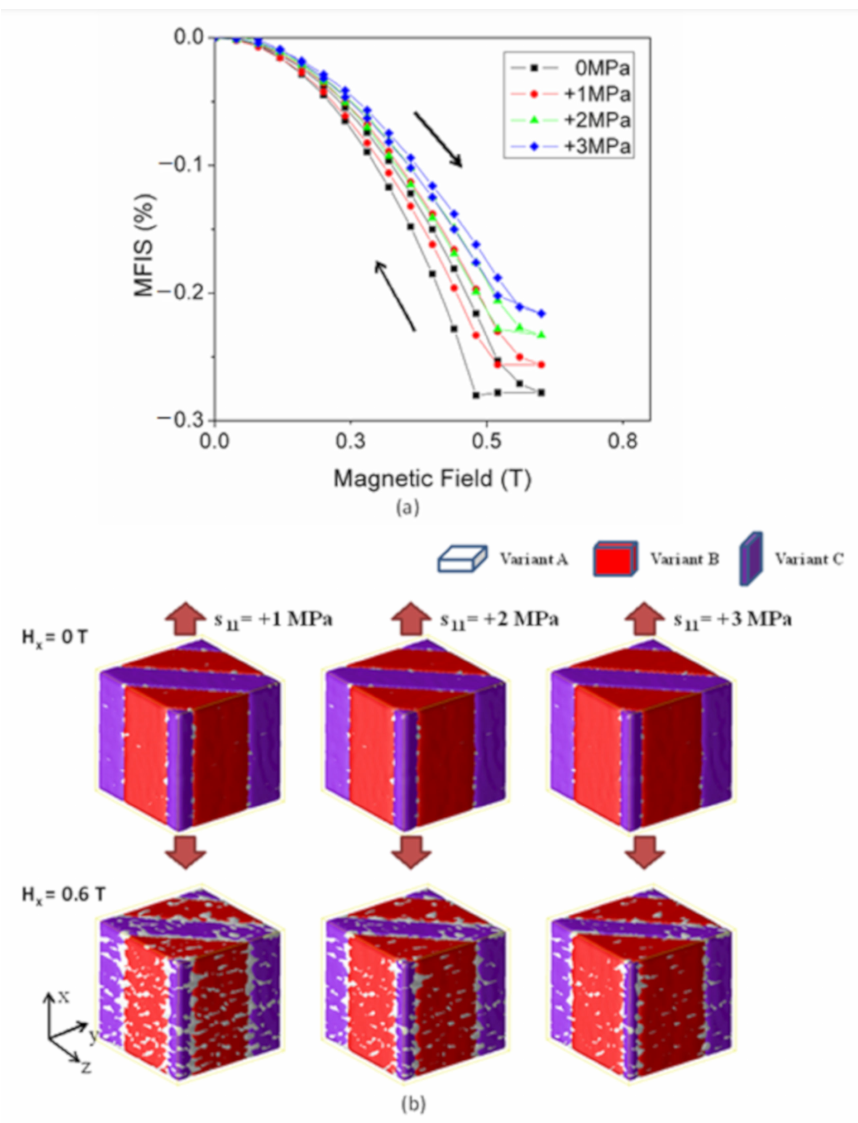
Figure 5. ( a ) MFIS loops with different applied tensile stress (along the x -axis) at 285 K; ( b ) simulated martensite variants at H x = 0 T and H x = 0.6 T.